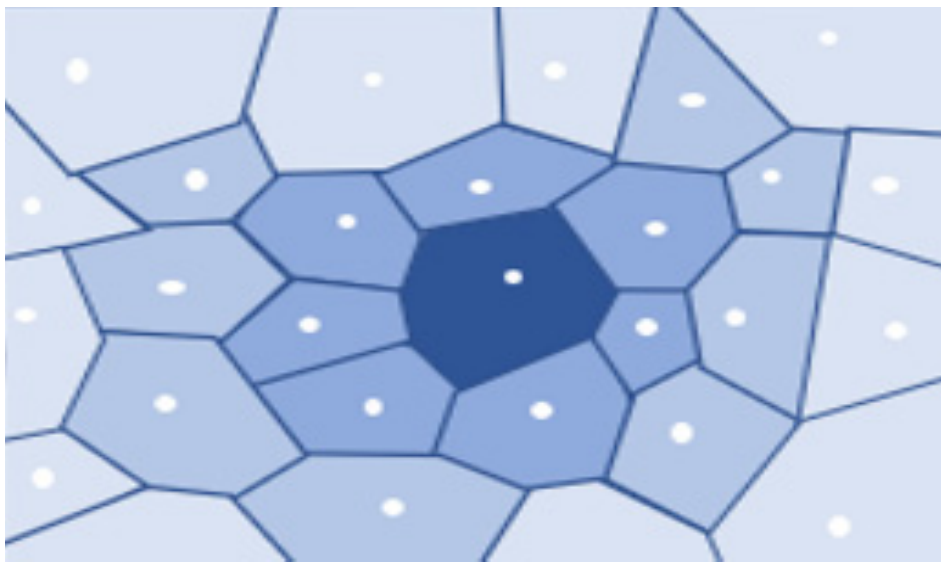
Figure 16. Voronoi